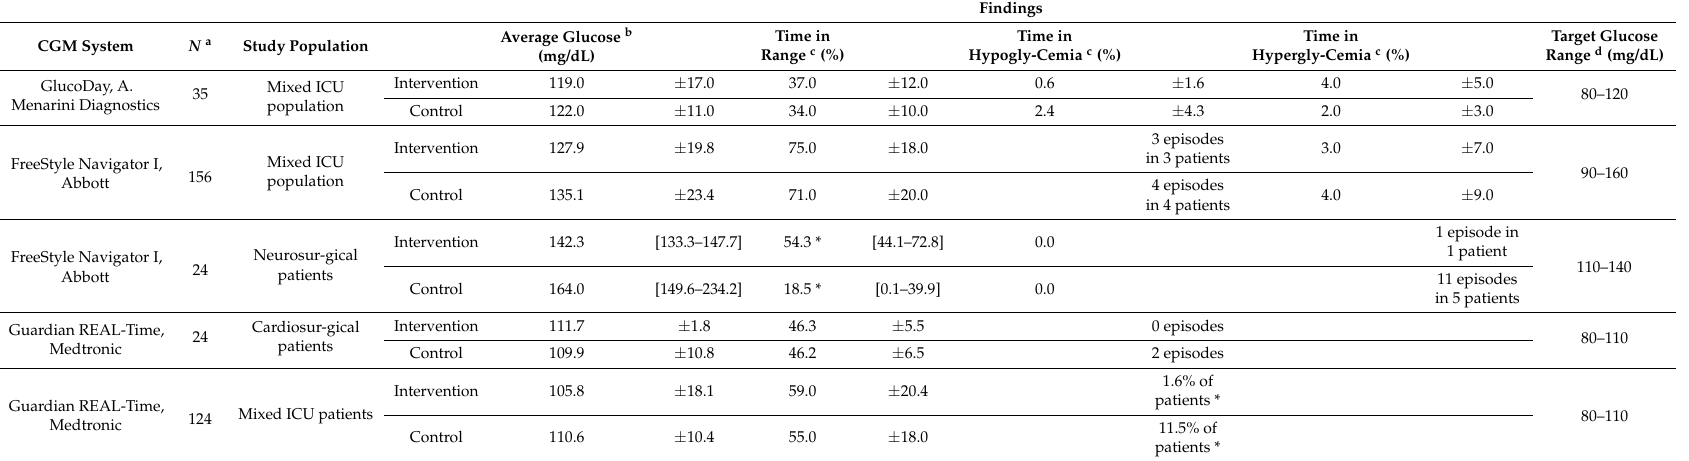
Table 2. Reported effectivity outcomes of randomized controlled trials assessing subcutaneous CGM systems ( n =